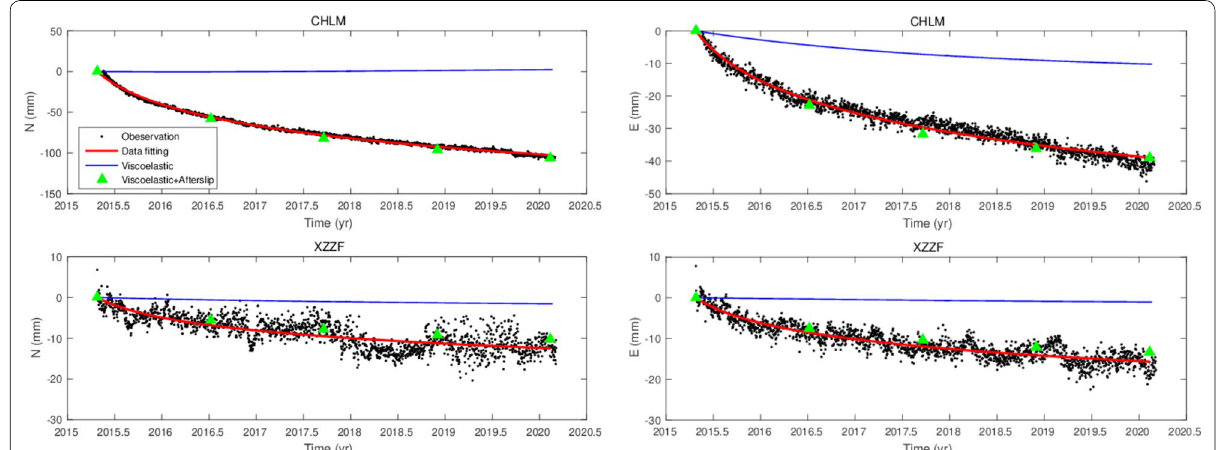
Fig. 8 The postseismic deformation daily displacement time series of the north and east components at GPS sites CHLM and XZZF. Black dots indicate the observed displacements. The red line indicates the data fitting of the postseismic deformation (Eq. 1). The blue line indicates the predicted viscoelastic relaxation. The green triangles indicate the sum of predicted viscoelastic relaxation and the postseismic deformation due to